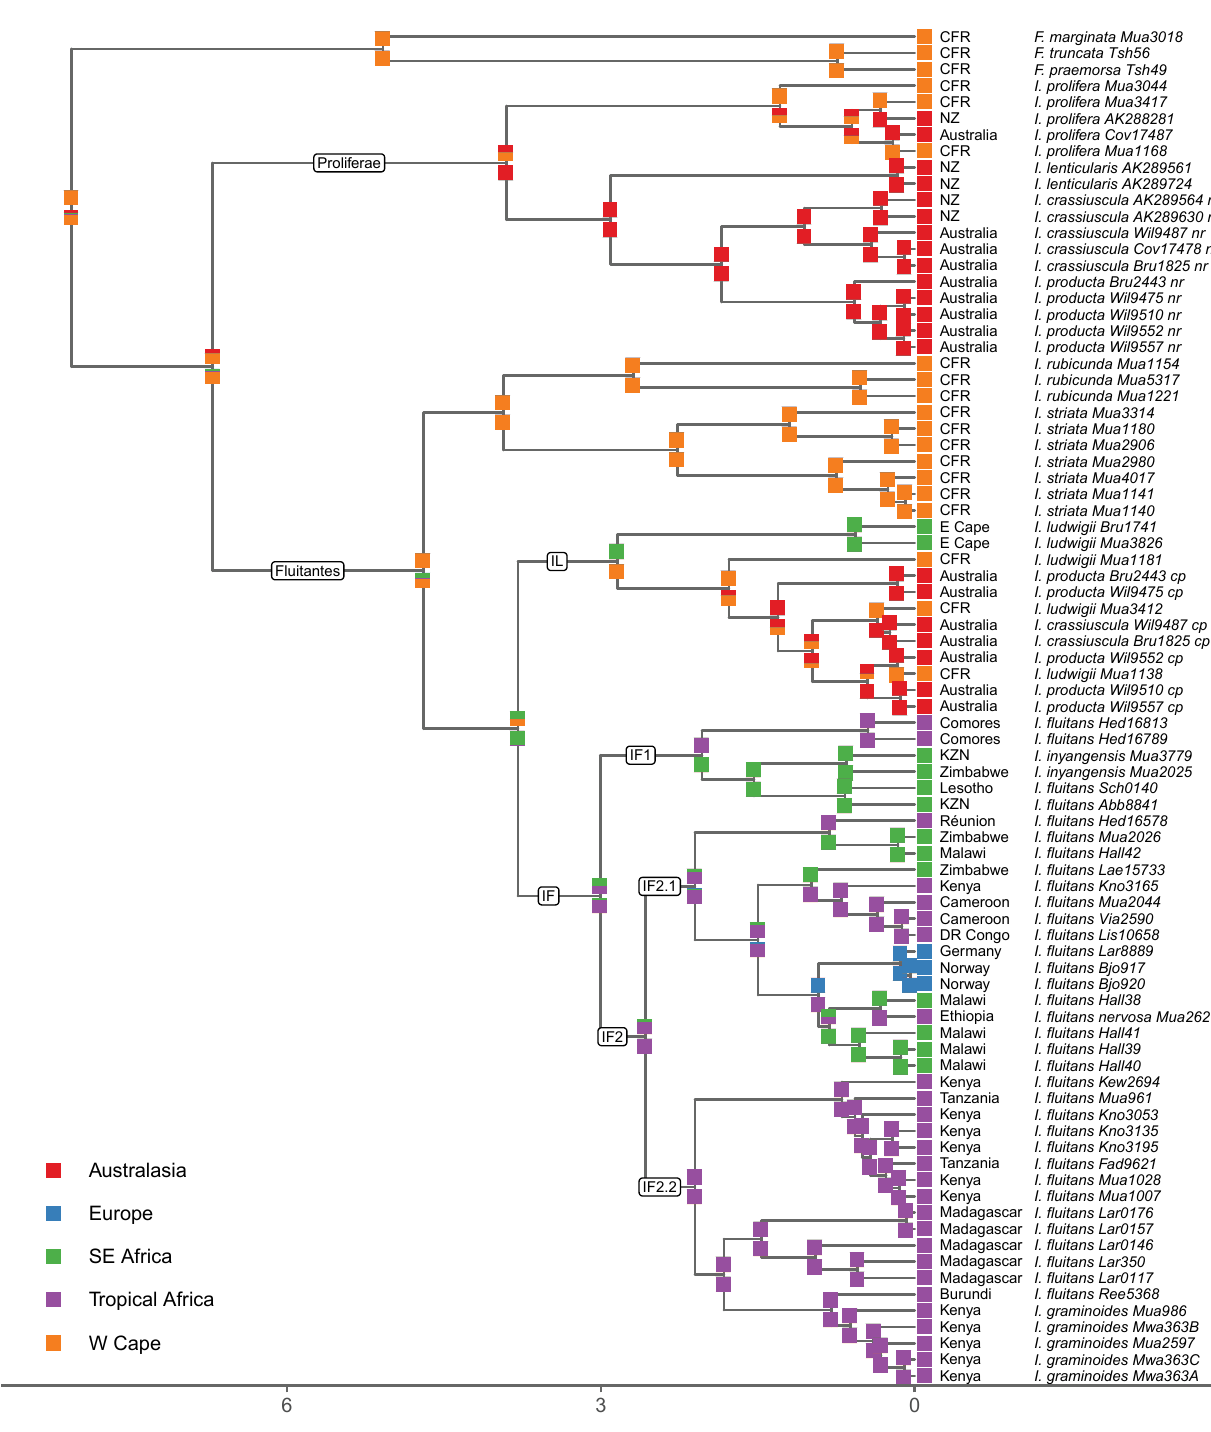
Figure 1 – Dated phylogeny of the Fluitantes clade showing proportional likelihood of ancestral areas of each lineage under the Stepping Stone model. The scale bar is in